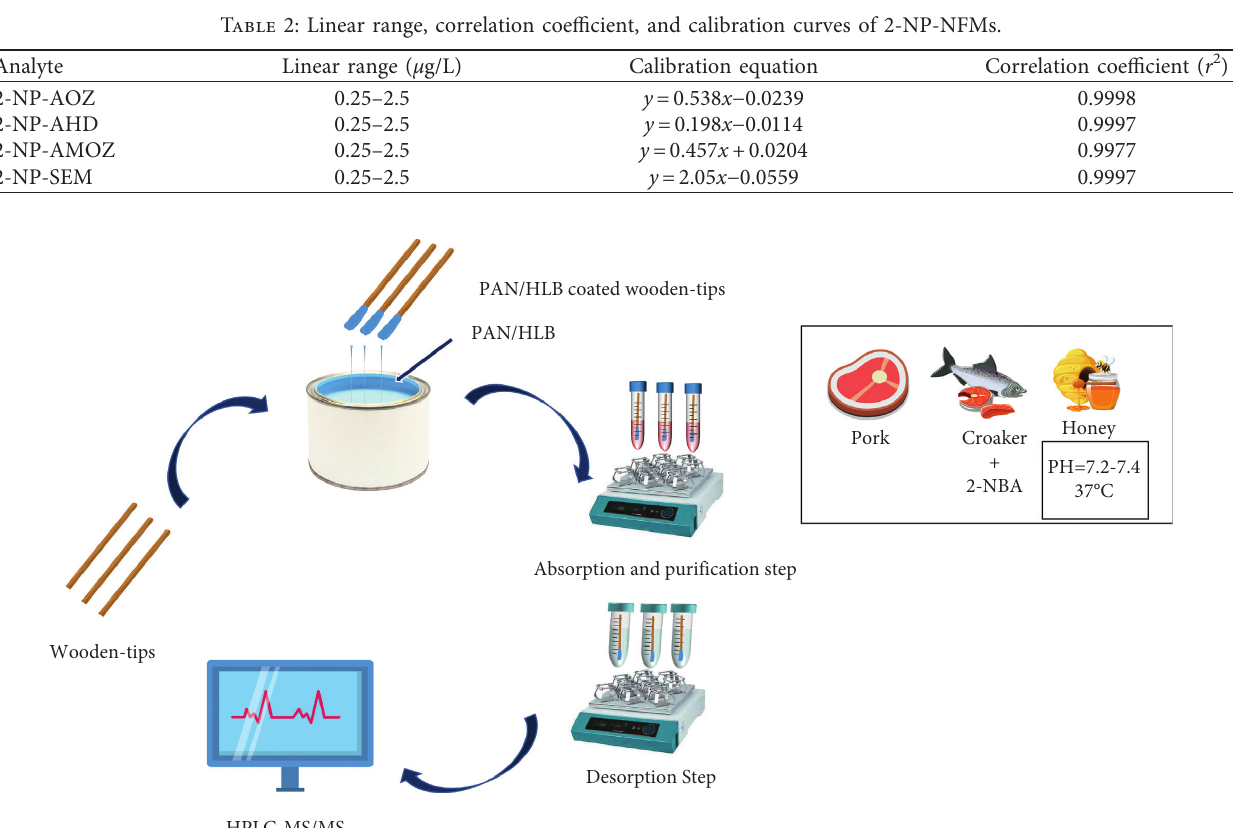
Figure 1: Schematic diagram of the procedure of wooden-tip-based SPME probe combined with LC-MS/MS for the detection of complex